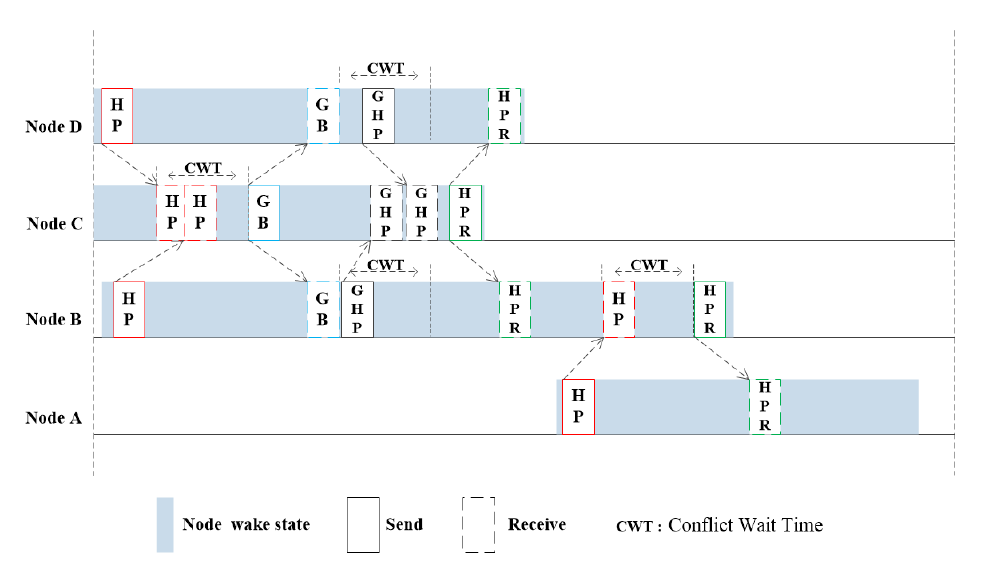
Figure 3. Channel contention game